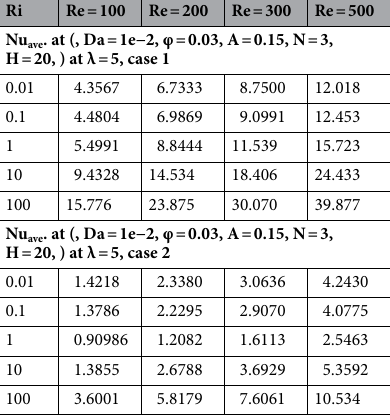
Table 16. Comparison of average Nu for Case 1 and Case 2 at different Ri and Re.